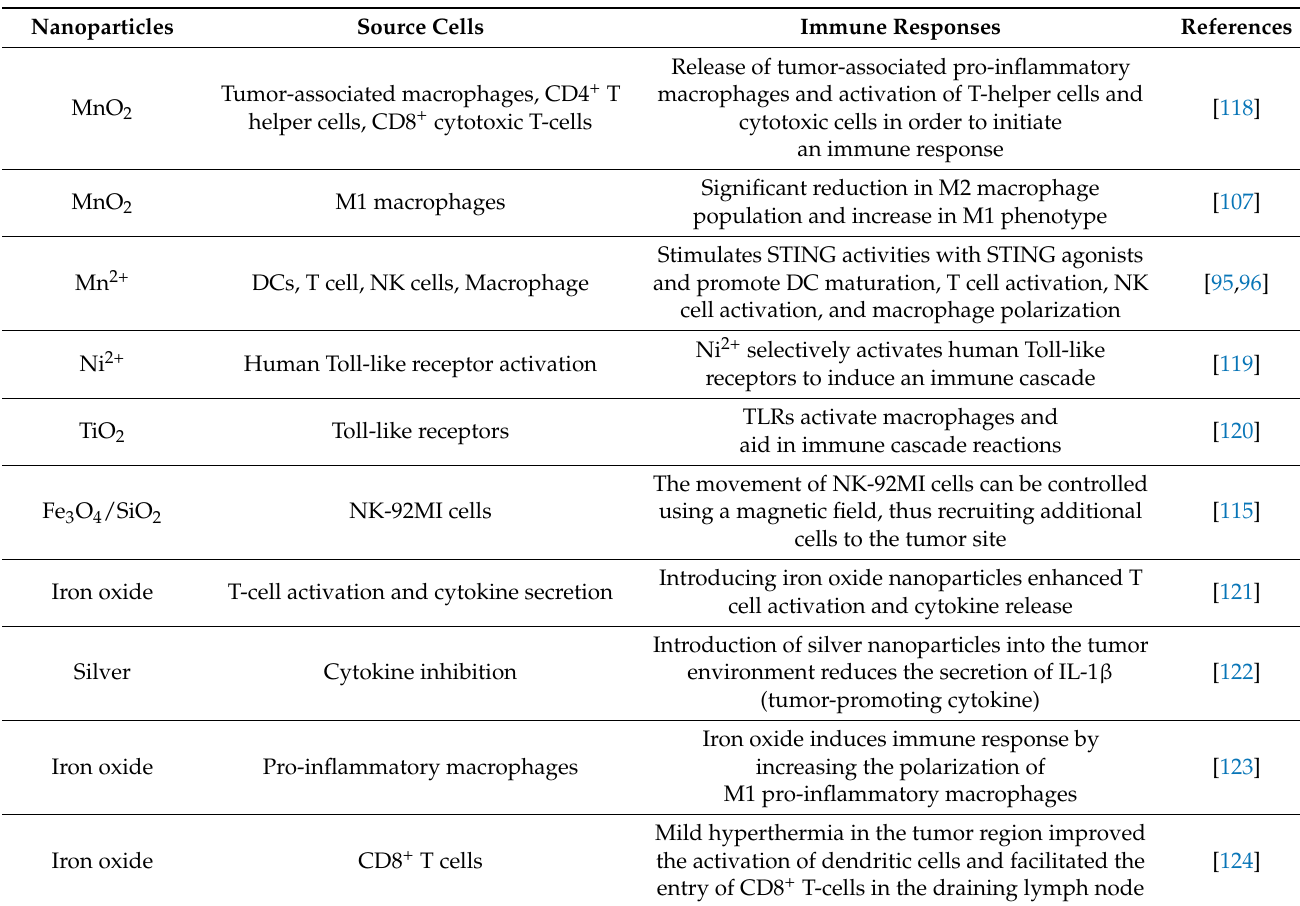
Table 2. Role of MNPs in immune